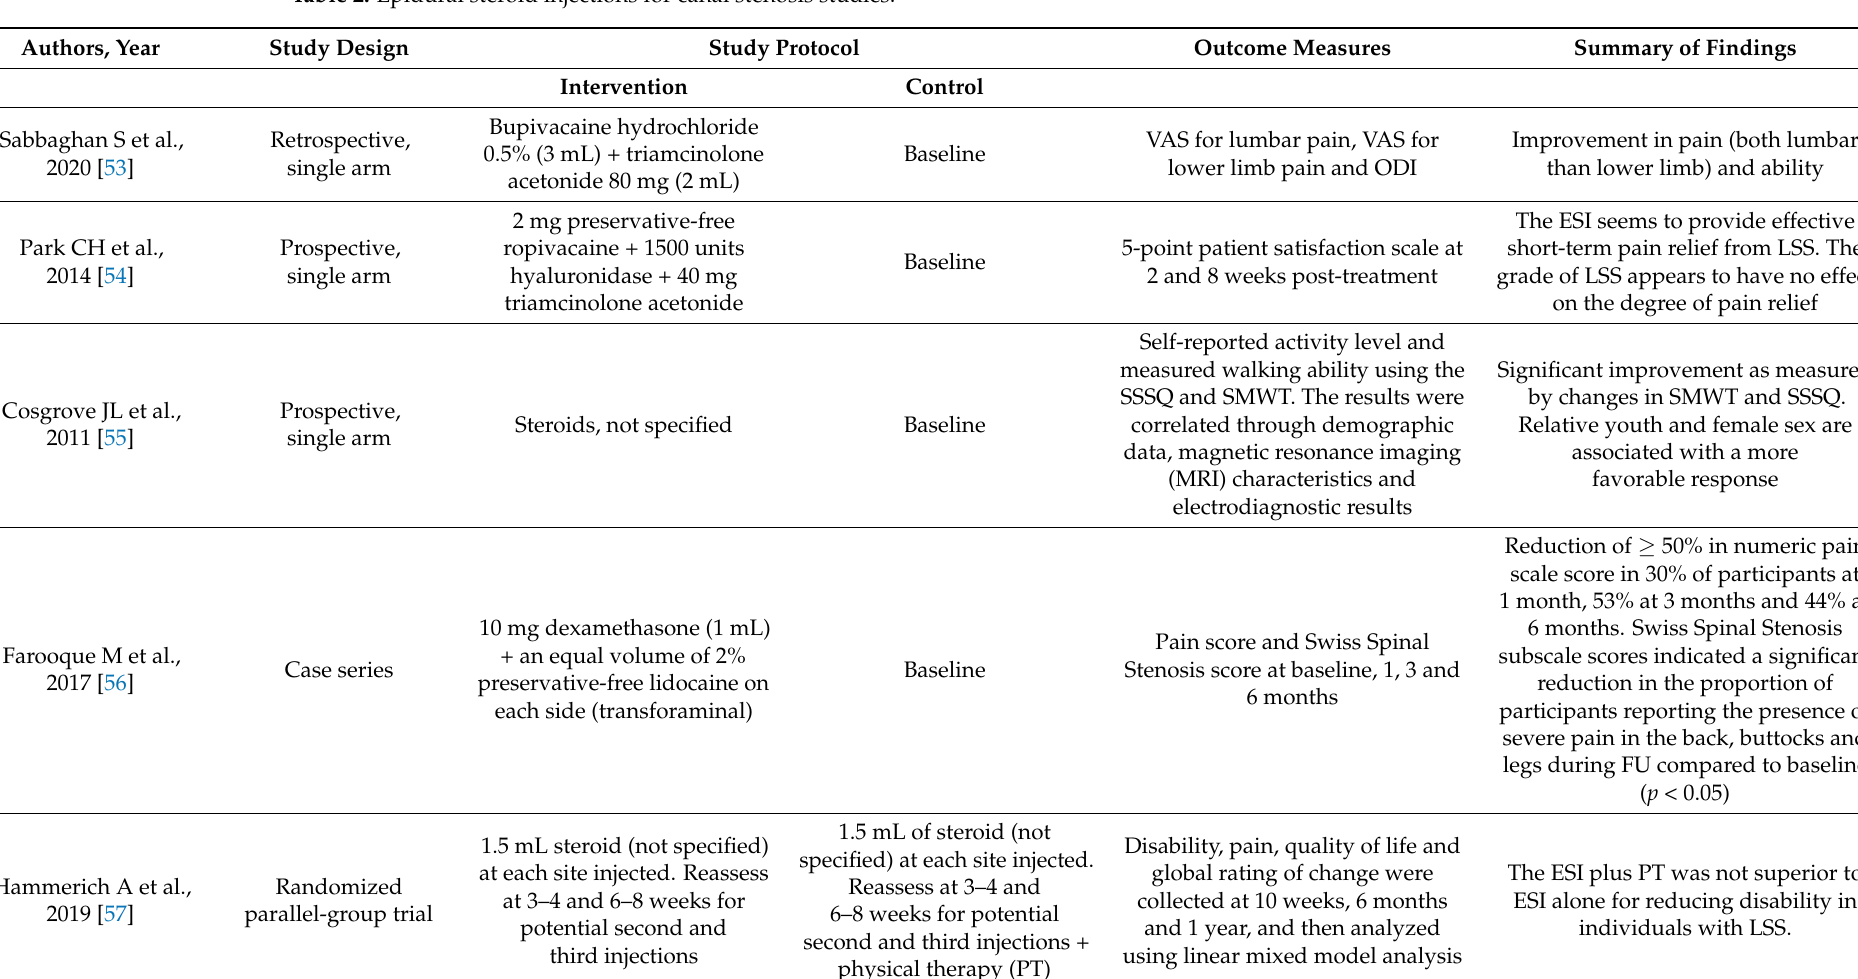
Table 2. Epidural steroid injections for canal stenosis